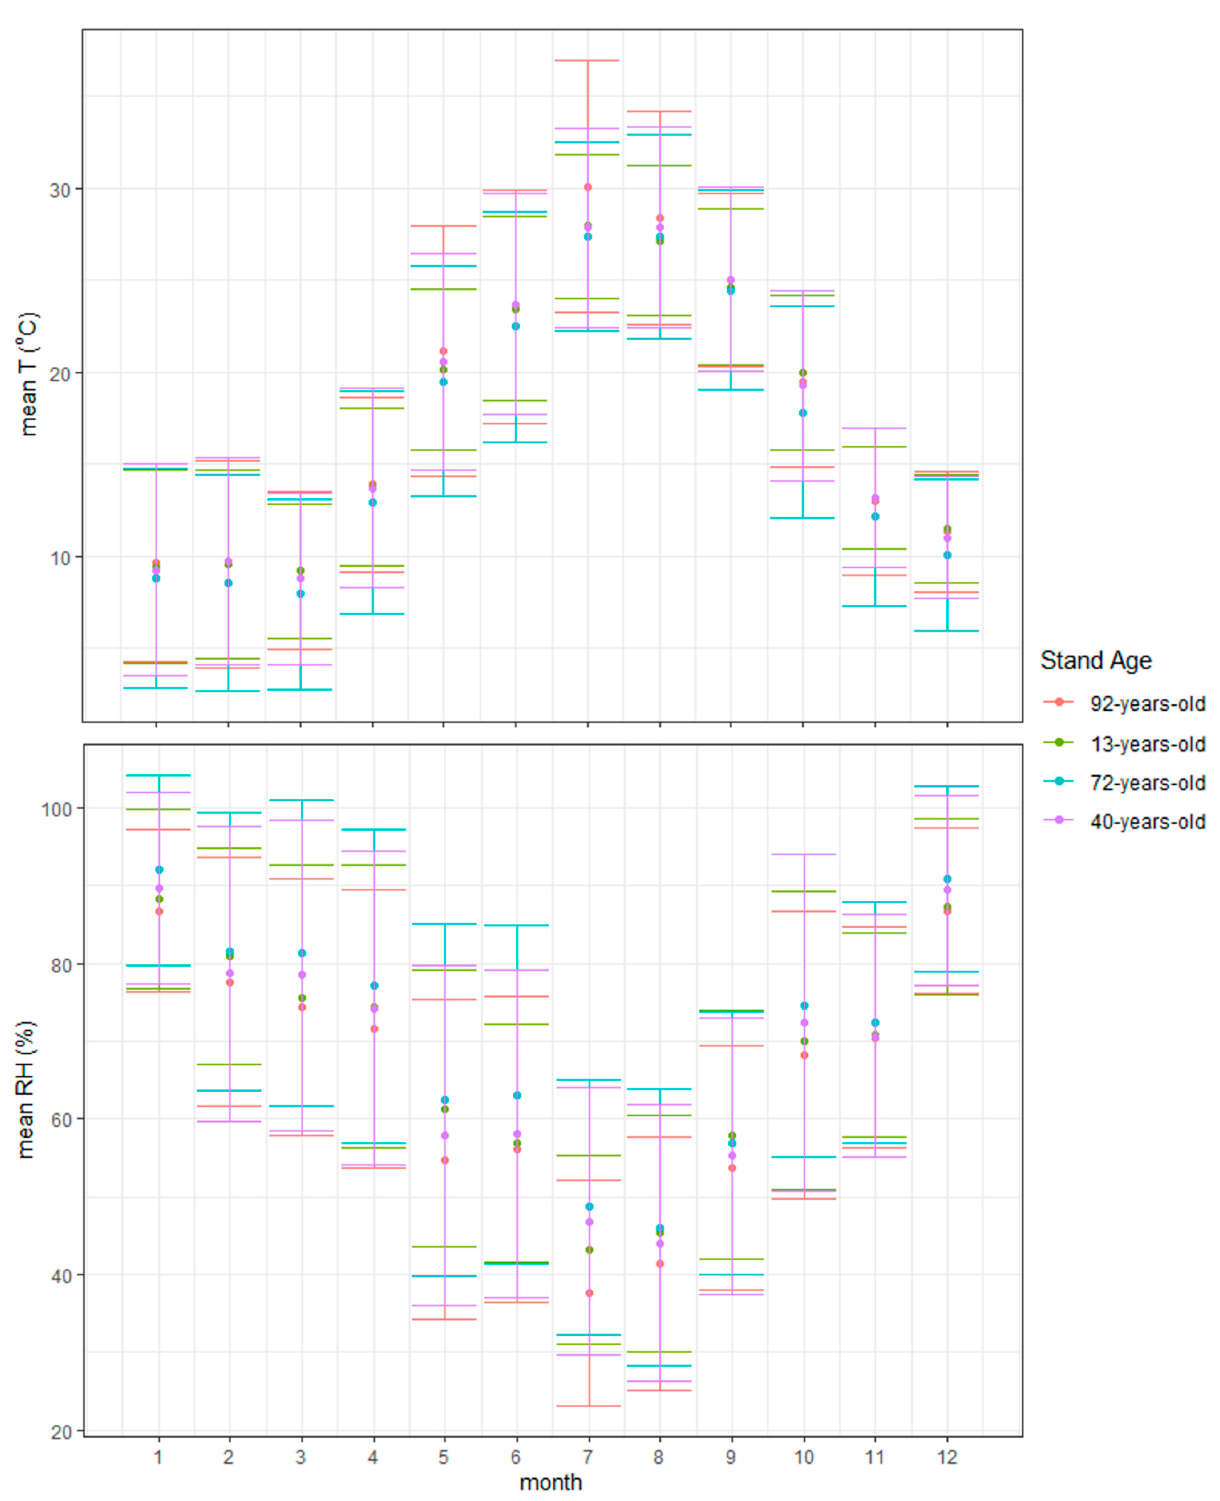
Figure A1. Average monthly temperature (T) (upper) and relative humidity (RH) (lower panel) and standard deviation.